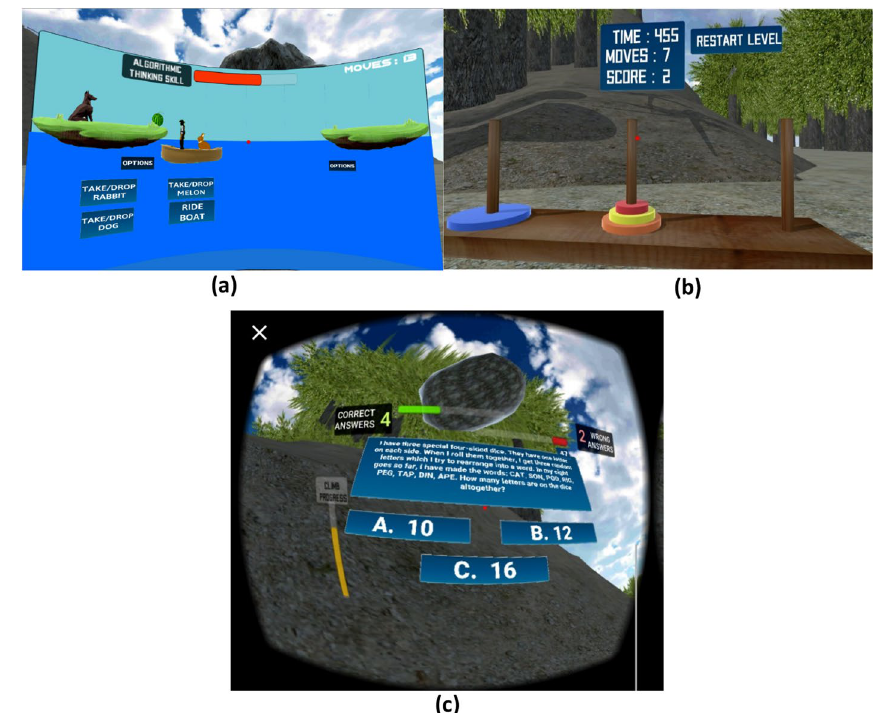
Fig. 3 Screenshot showing the iThinkSmart VR mini games: a river crossing; b tower of Hanoi challenge; c